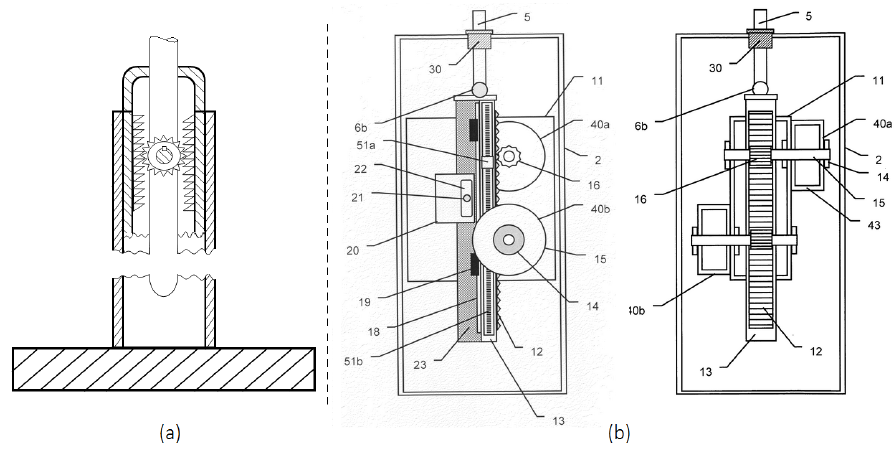
Figure 13. Rack and pinionmechanisms: ( a ) double rack system adapted from [98] and ( b ) double pinion system, reproduced with kind permission from Ocean Power Technologies as published in their US Patent US 8487459 B2, 14 April 2011